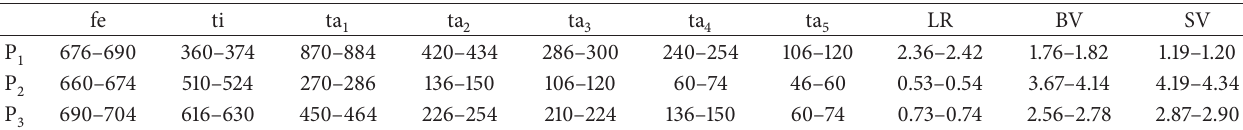
Table 2: Lengths ( 𝜇 m) and proportions of leg